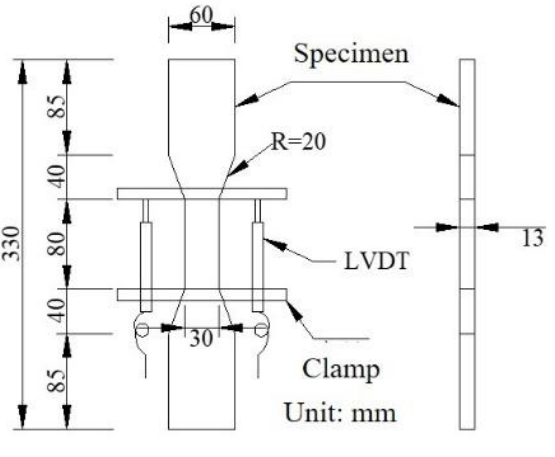
Figure 1. Dumbbell specimen.